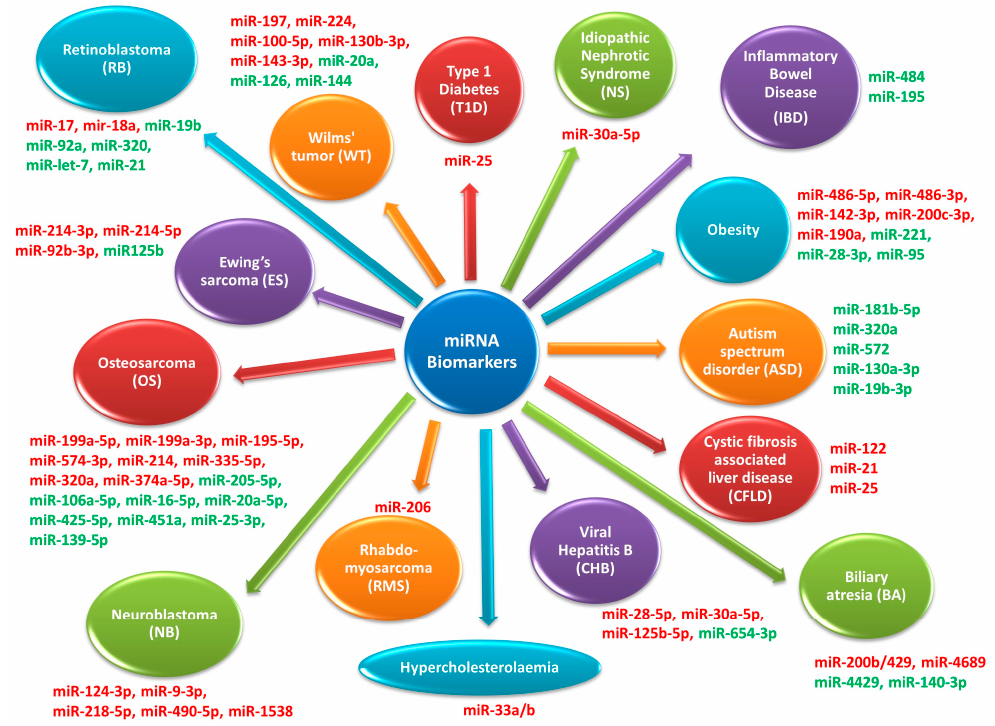
Figure 2. Circulating miRNAs detected in different pediatric diseases. Up- and down-regulated miRNAs are represented in red and green, respectively.